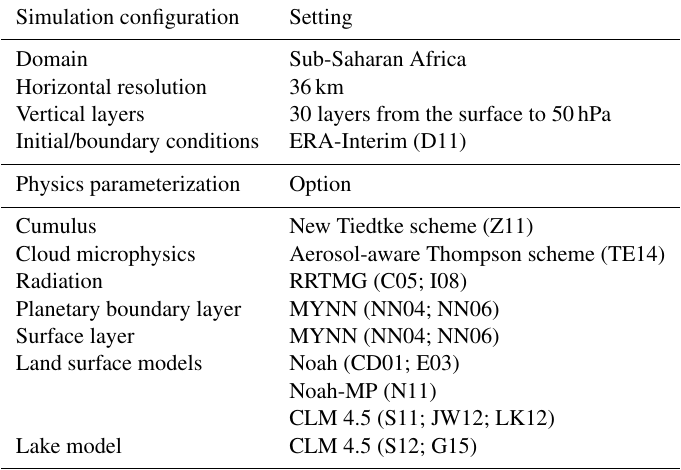
Table 1. Model configurations.